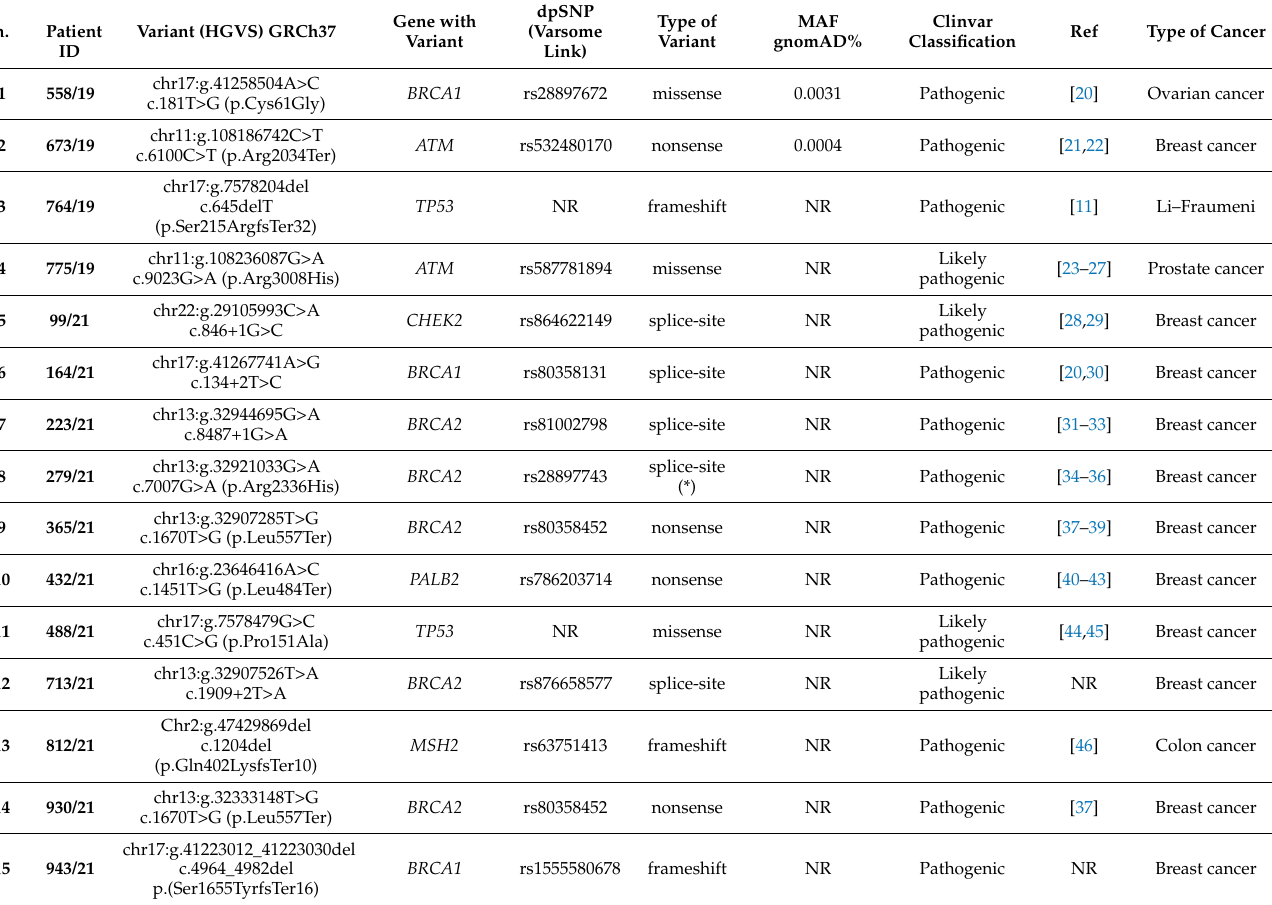
Table 2. VUS variants found in HCPS patients.